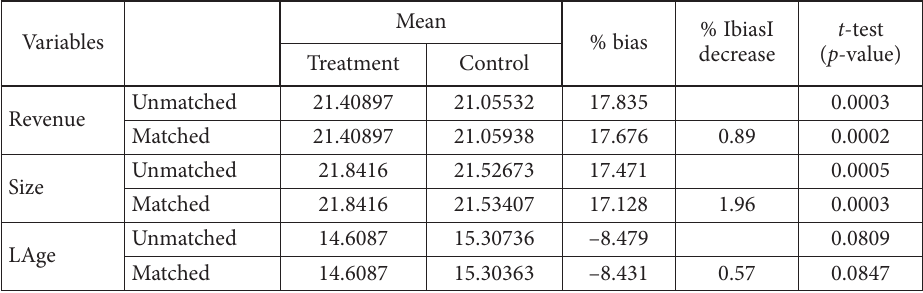
Table 2. Equilibrium diagnosis for PSM sample (source: author’s calculation)